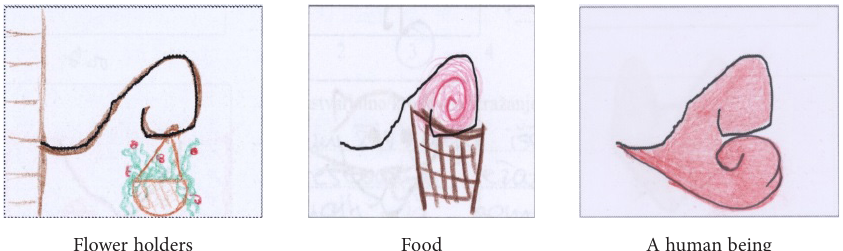
Figure 16. The creative task: interpretation of Fragment 2 – exceptional images (source: testingmom.com,